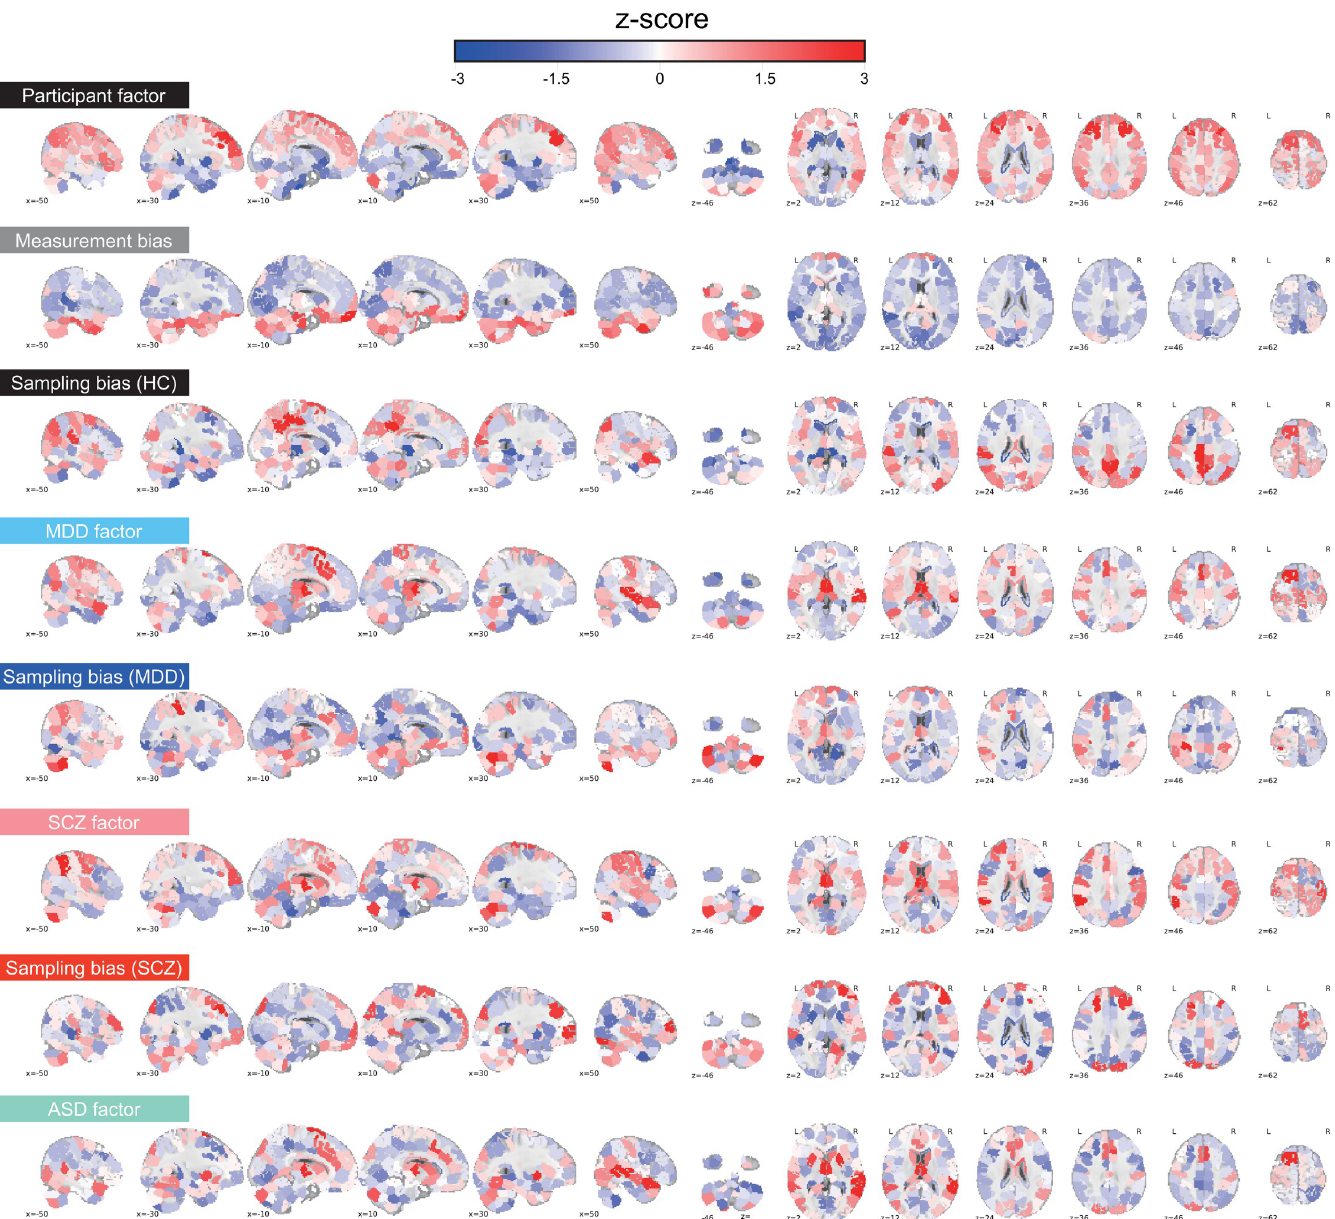
Fig 3. Spatial distribution of each type of bias and each factor in various brain regions. Mean effects of connectivity for all 268 ROIs. For each ROI, the mean effects of all functional connections associated with that ROI were calculated for each bias and each factor. Warmer (red) and cooler (blue) colors correspond to large and small effects, respectively. The magnitudes of the effects are normalized within each bias or each factor ( z -score). The numerical data used in this figure are included in S1 Data. ASD, autism spectrum disorder; HC, healthy control; MDD, major depressive disorder; ROI, region of interest; SCZ,